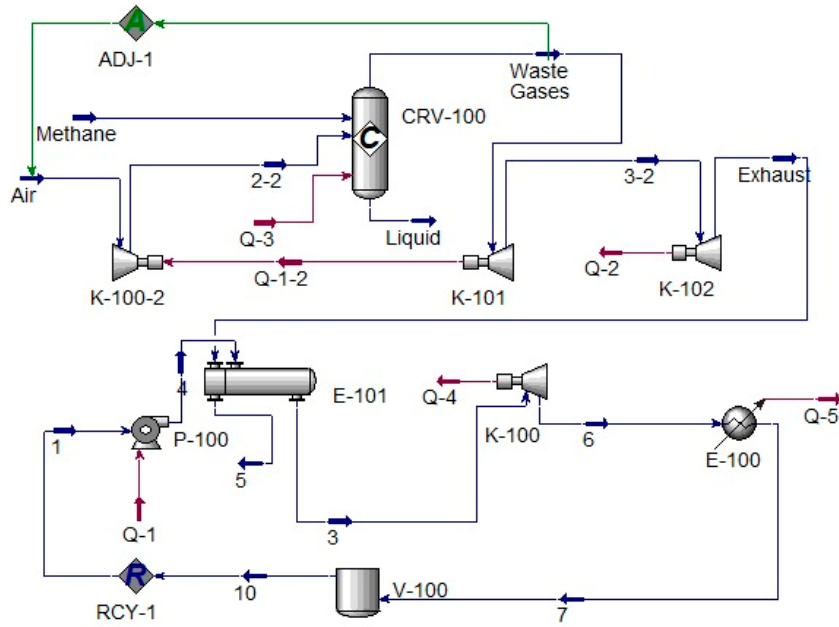
Figure 3. The simulation model of the system in Aspen HYSYS.